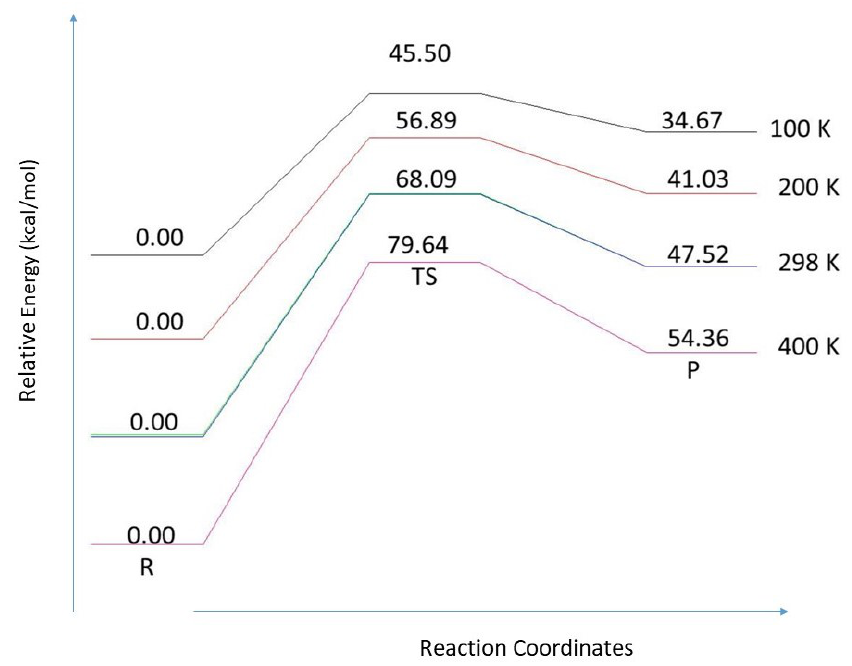
Figure 10. Effect of finite temperature on the relative Gibbs free energy for the reaction path 3 for isomer S1 of the (TiO 2 ) 6 cluster. Notice that the different curves have different zero-energy